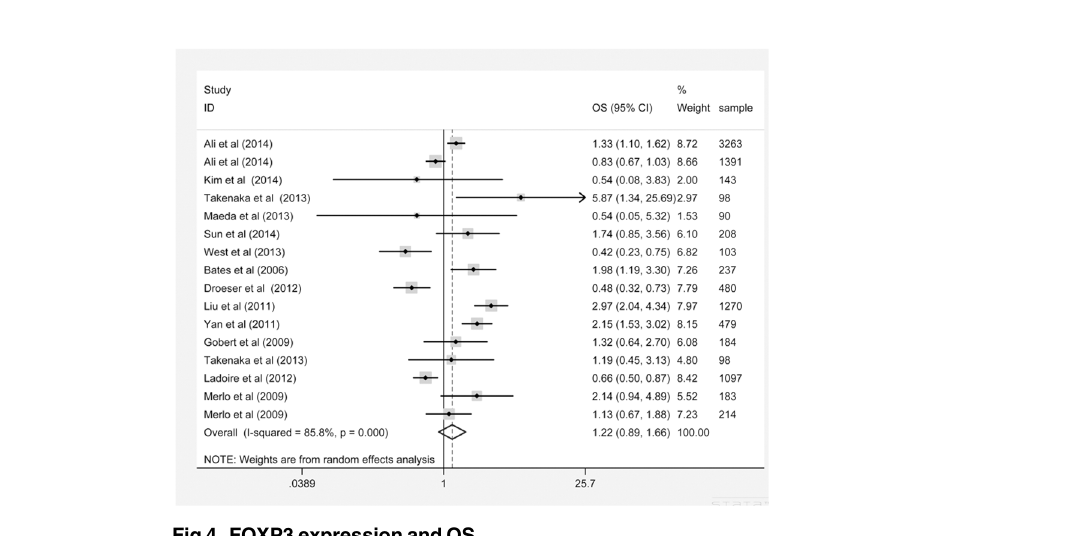
Fig 4. FOXP3 expression and